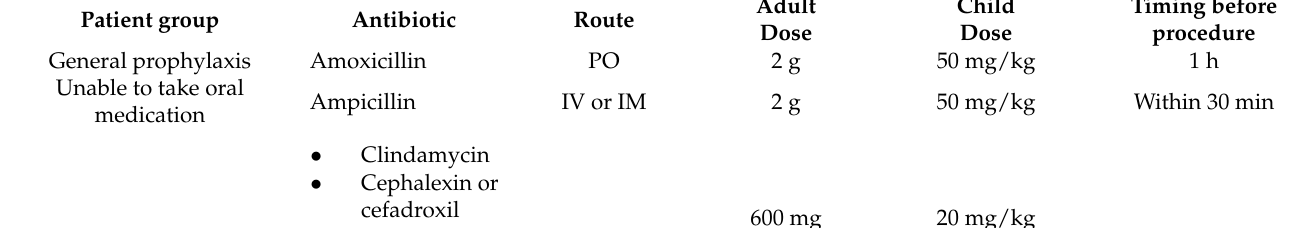
Table 5. Recommendations on antibiotic prophylaxis regimens in endodontics according to the European Society of Endodontology position statement: the use of antibiotics in endodontics [25]; American Association of Endodontics—Antibiotic Prophylaxis 2017 Up- date [22]; Scottish Dental Clinical Effectiveness Programme—Antibiotic Prophylaxis Against Infective Endocarditis—Implementation Advice 2018 [8]; and the Belgian Health Care Knowledge Centre (KCE) Report 332 [21]. European Society of Endodontology Position Statement: The Use of Antibiotics in Endodontics [25] Patient